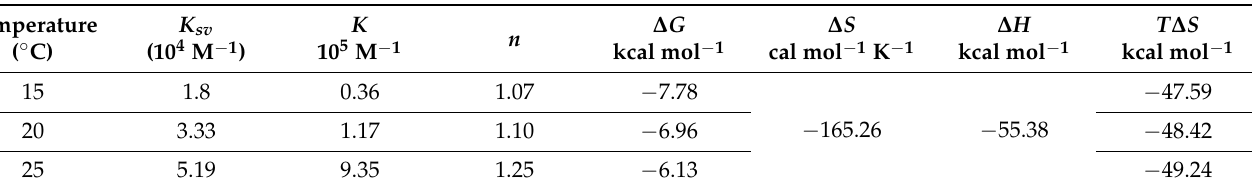
Figure 9. Fluorescence emission spectra of HSA in the absence and presence of varying HpzA con-